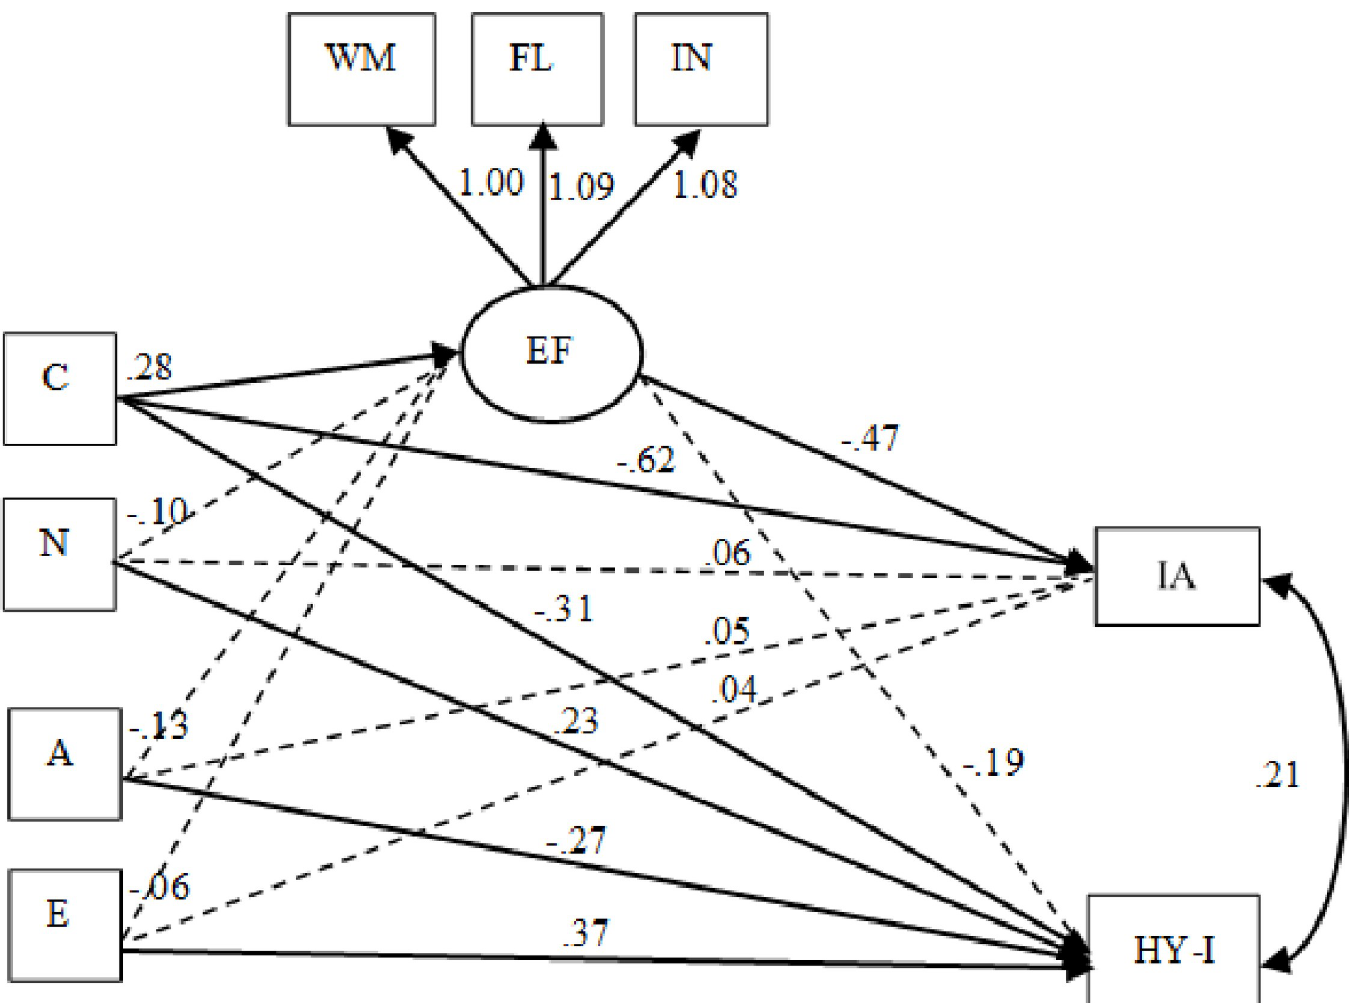
Fig 1. Structural equation model of relationship between cognitive executive function, personality traits and inattentive and hyperactive-impulsive symptoms. N = 118. Solid lines show unstandardized paths coefficients, significant at the p < .001 level. Dashed lines are non-significant paths. EF: executive function; WM: working memory; FL: flexibility; IN: inhibition. Personality traits; C: Conscientiousness; N: Neuroticism; A: Agreeableness; E: Extraversion. IA: inattentive, HY-I: hyperactive-